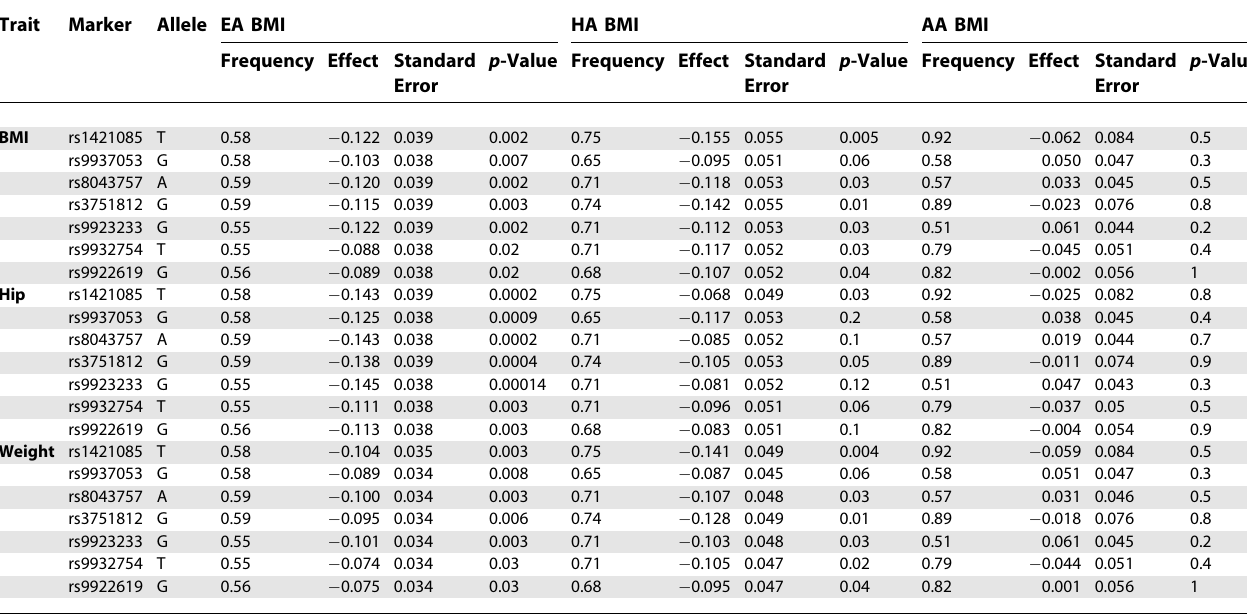
Table 4. Fine-Mapping Results for FTO Region in GenNet Sample Trait Marker Allele EA BMI